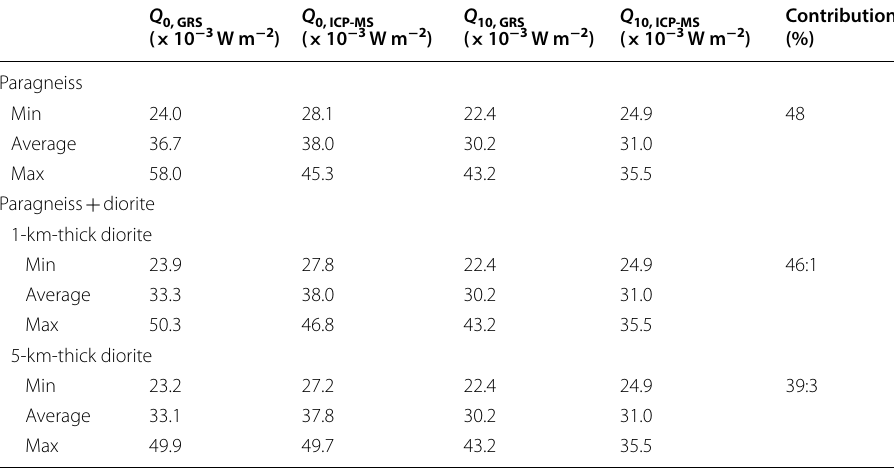
Table 5 Inferred heat flux and contribution from each layer